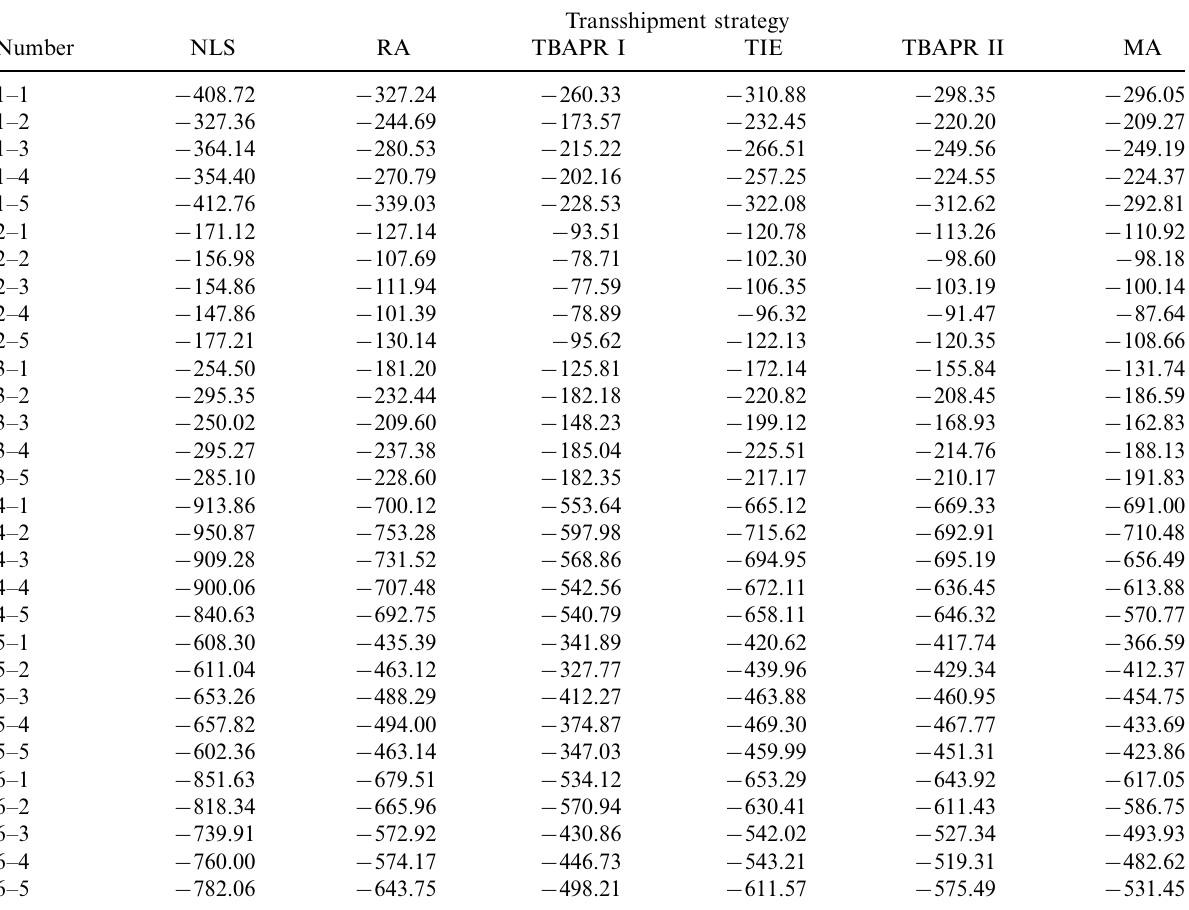
Table 3. Shortage amount in the three retailers system